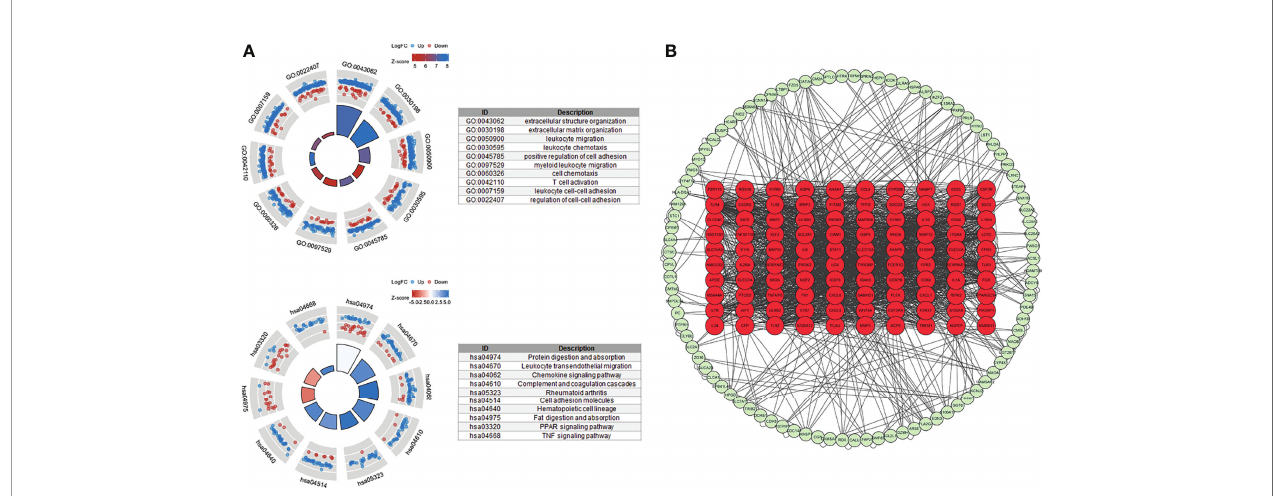
FIGURE 4 | Functional enrichment and PPI networks. (A) Top 10 GO BP and KEGG enrichments. (B) PPI network of response-related DEGs; top 100 nodes were presented by red circles.